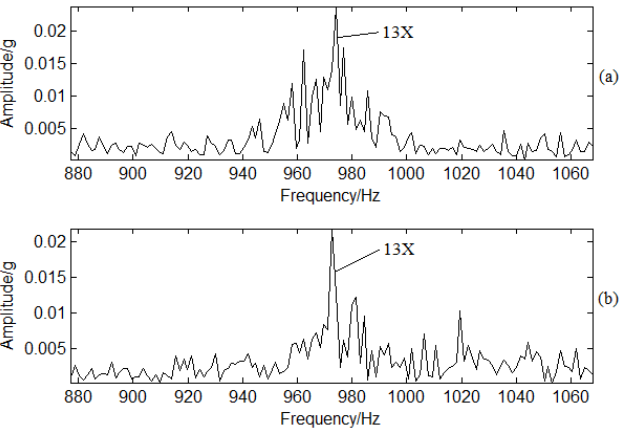
Figure 16. Enlarged vibration signal frequency spectrum analysis under different working conditions: ( a ) Normal conditions; ( b ) Crack conditions.